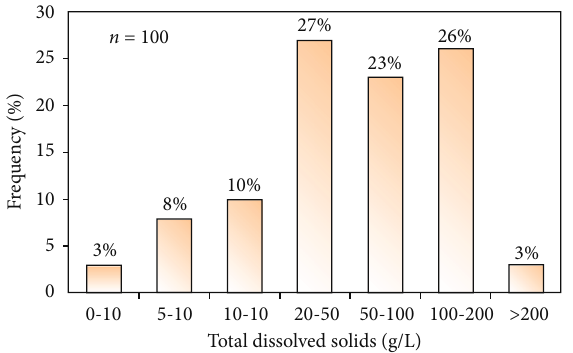
Figure 3: Frequency distribution map of total dissolved solids